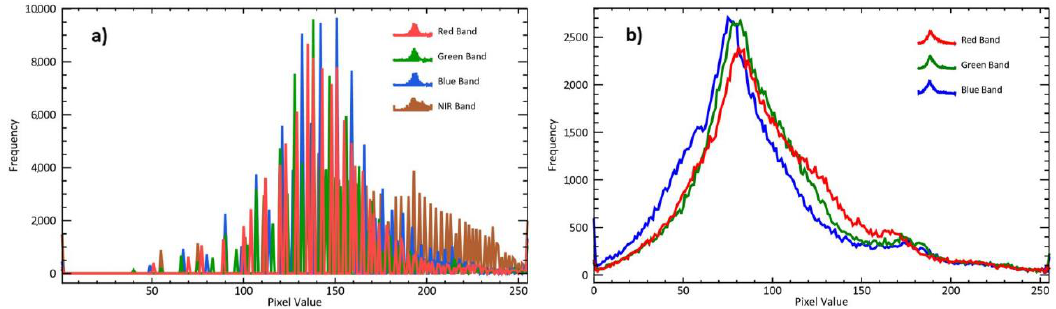
Figure 4. Spectral profile with pixel values on the X -axis and frequency on the Y -axis: ( a ) 2005 satellite image with four bands (red, green, blue and near-infrared) and ( b ) 2016 Google Earth images with three bands (red, green and blue).